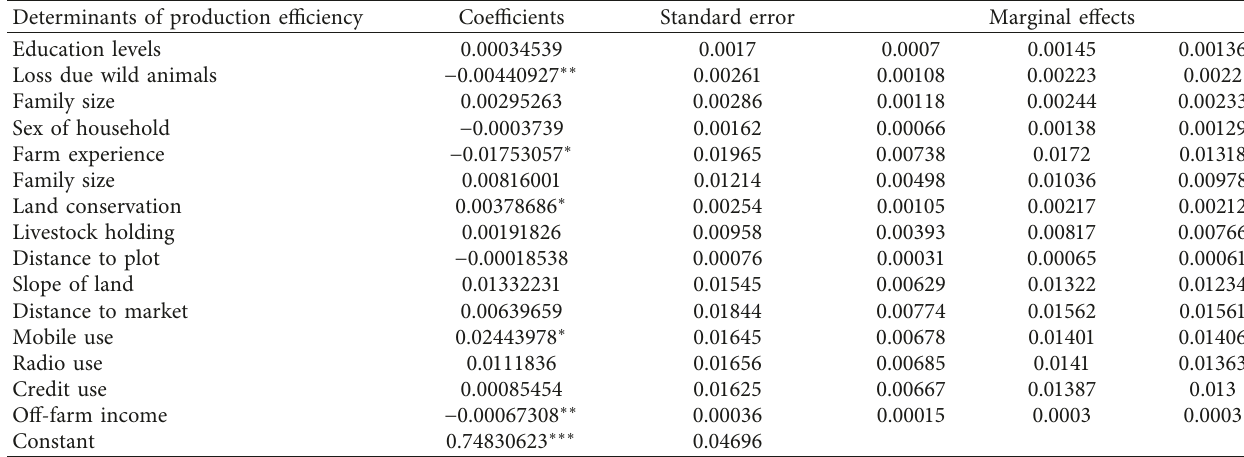
Table 4: Determinants of production efficiency and its marginal